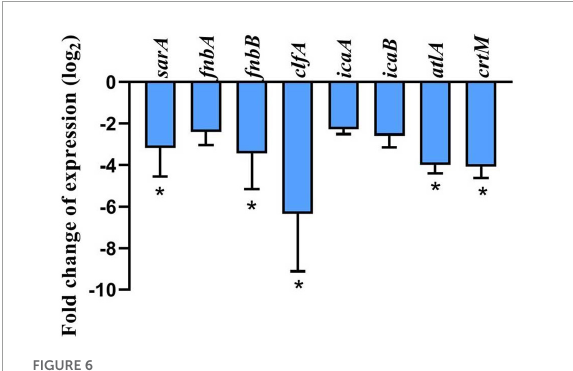
FIGURE6 Effect of geraniol at 256 µ g/mL concentration (half of the minimum inhibitory concentration) on the expression of genes involved in biofilm formation and related virulence factors of USA300. ∗ p < 0.05 compared with the 0 µ g/mL group.